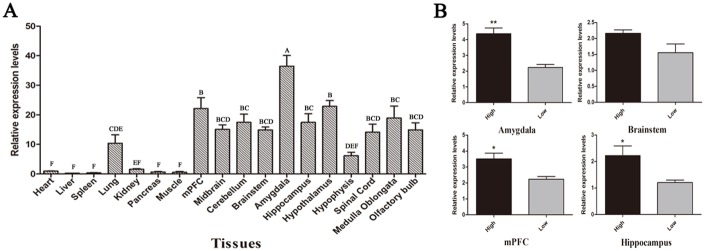
STMN1 gene expression in different canine tissues.(A) Canine Stathmin 1 (STMN1) mRNA expression profiles in 18 tissue types, determined in triplicate. The mean heart level was set to 1. Different capital letters on the bars indicate significant differences (P < 0.01) (B) STMN1 expression level in the low and high fear level groups (n = 5/group) in the amygdala, brainstem, medial prefrontal cortex (mPFC), and hippocampus, respectively. The mRNA levels were normalized to β-actin mRNA levels. *P < 0.05; **P < 0.01.